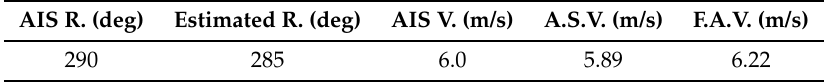
Table 1. Kinematics estimation output. R stands for Route and V for Velocity. The presented velocity results correspond respectively to the Azimuth Shift (A.S.V.) method and to the Fourier Analysis method (F.A.V.).